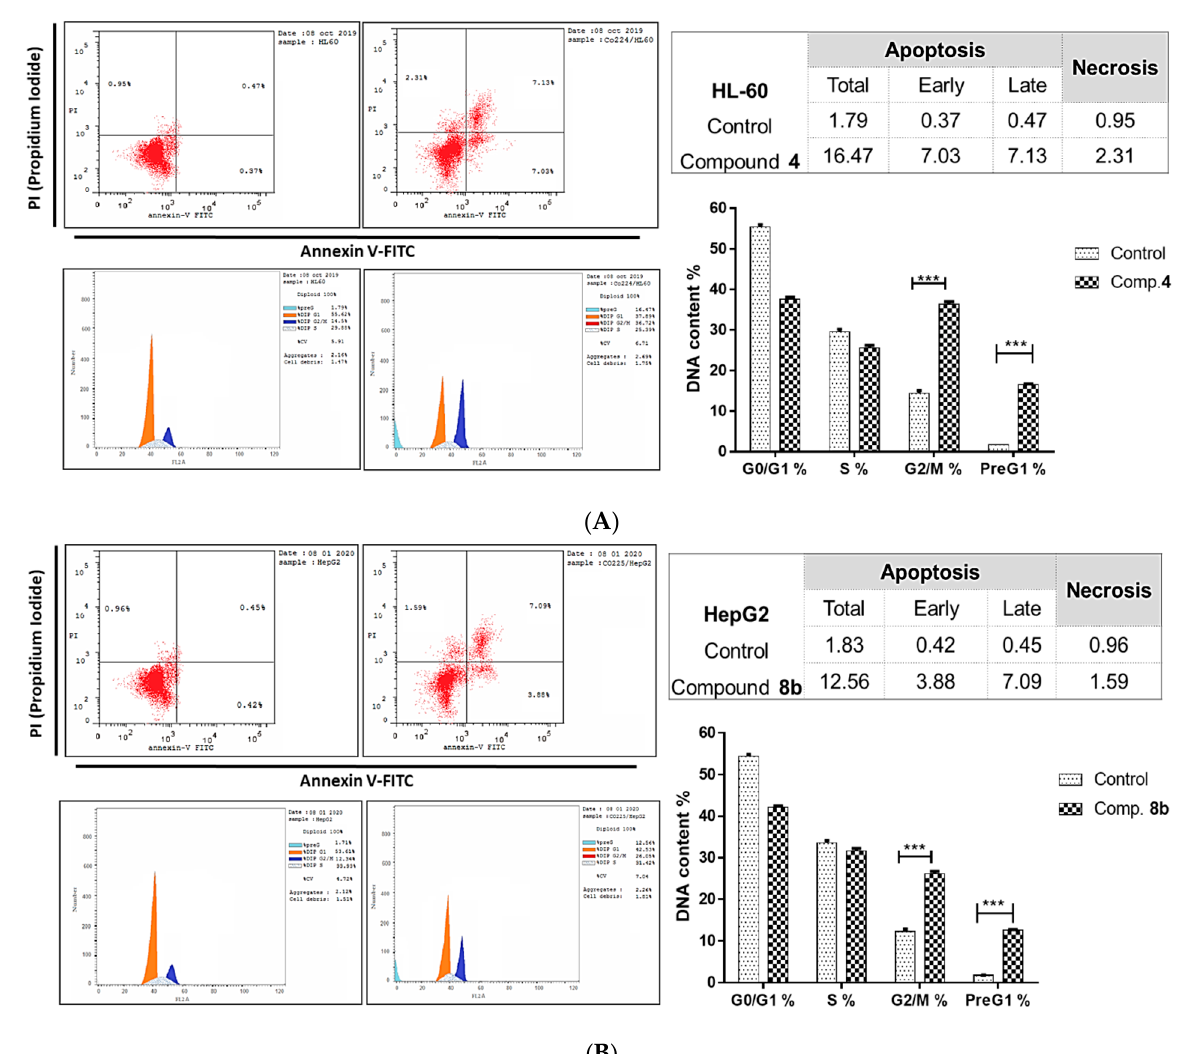
Figure 3. Cytogram showing annexin-V/propidium-iodide-stained “Quadrant charts show Q2-1 (necrotic cells, AV − /PI+), Q2-2 (late apoptotic cells, AV+/PI+), Q2-3 (normal cells, AV − /PI − ), Q2-4 (early apoptotic cells, AV+/PI − )” and the cell-cycle distribution of both untreated and treated HL60 treated with compound 4 (IC 50 = 8.09 µM, 48 h, ( A ) and HepG2 cells treated with compound 8b (IC 50 = 13.14 µM, 48 h, ( B ), with a bar chart representation of cell-population percentages in different cell-cycle phases. ***: p <